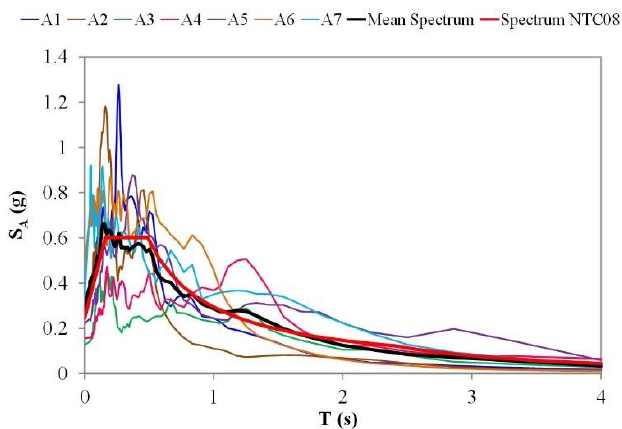
Figure 7. Response spectra related to the seven natural accelerograms (A1 to A7, representative of soil class B) used within the numerical